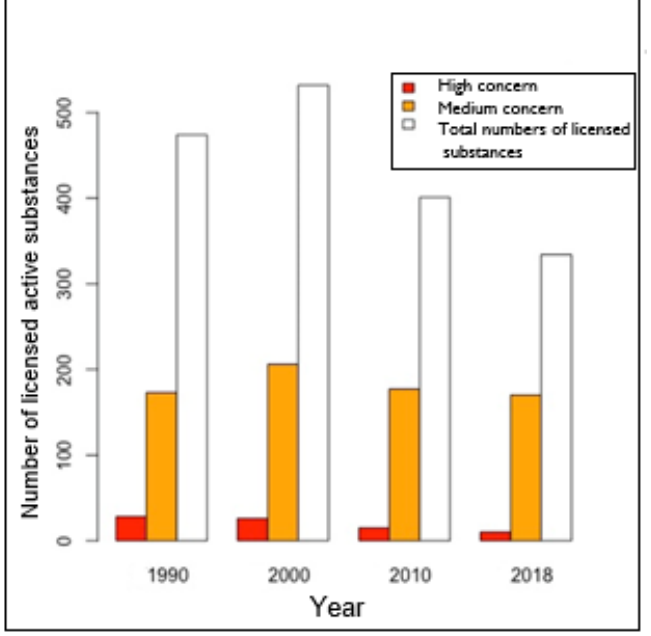
Figure 3. Evolution of the number of licensed phytopharmaceutical active substances in France classified as having a ‘high’ or ‘potential concern’ for endocrine disruptor or toxicity for an endocrine organ, using our ED/TEG indicator since 1990 .